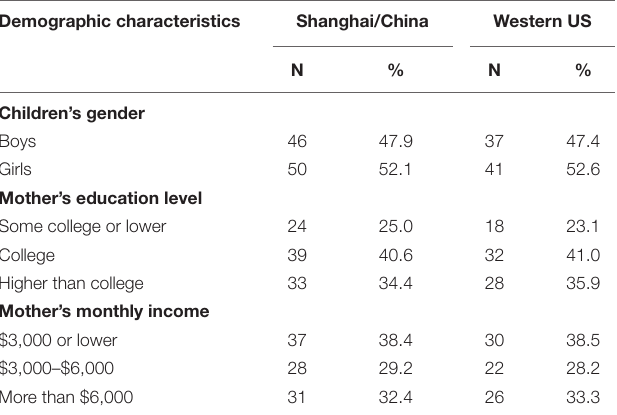
TABLE 1 | Demographic characteristics of mothers and